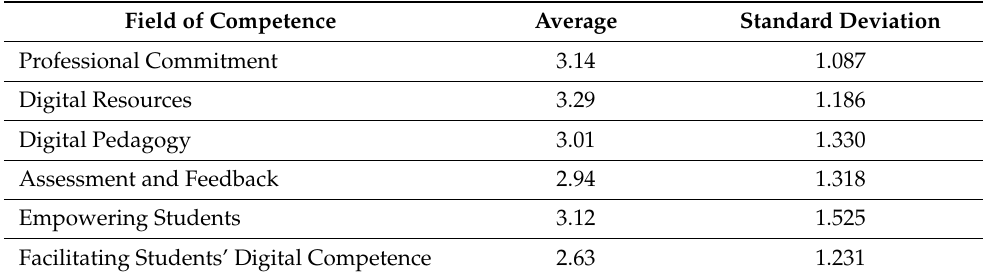
Table 2. Values obtained in each field of competence.